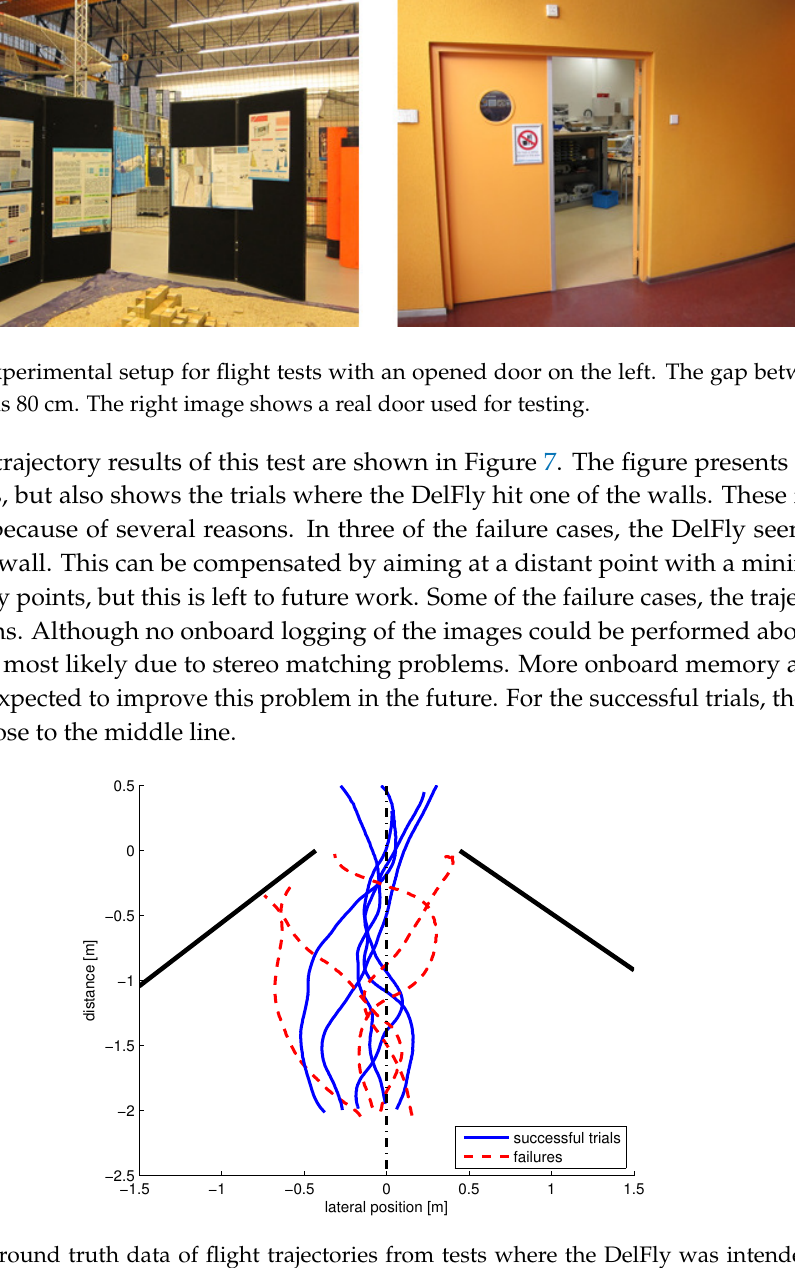
Figure 7. Ground truth data of flight trajectories from tests where the DelFly was intended to fly through a simulated ‘door’ inside a motion tracking flight arena. The door is formed by two walls, indicated by the thick black lines on the side. The width of the door opening is 80 cm (see the left image in Figure 6). The DelFly starts each trial around the − 2 m line. The vertical line indicates the middle line. Five successful trials are depicted and four failures. In three failures, the navigation would aim too close to the edge of the door. In one case, a bad detection or lack of texture is expected to have played an important